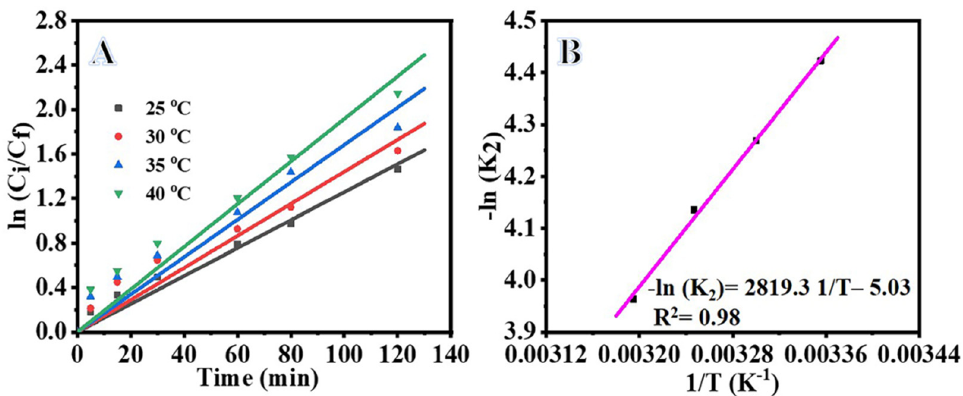
Figure 6. Influence of reaction temperature on photodegradation of MB ( A ), ln Ci/Cf vs. time ( B ), Arrhenius plot for MB photodegradation. The parameters are: photocatalyst amount = 0.2 gm L − 1 , C i = 0.1 M, and I = 25 W m − 2 .